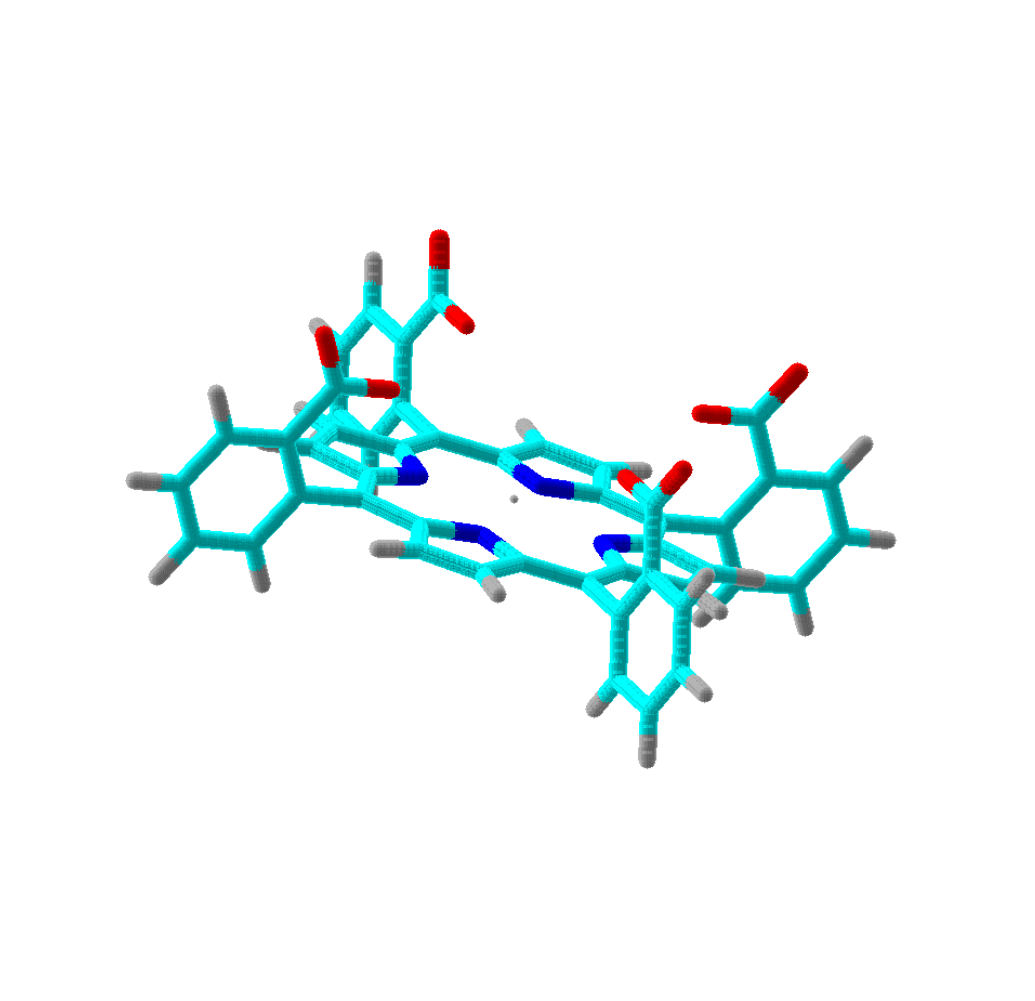
Figure 4. One of the conformers of MnT(2-C)PP shown as a tube structure in 3D. It corresponds to conformer (+,+,+,+) in Figure 3. Dark blue are nitrogens in the pyrrole rings. Red tubes are oxygens in the carboxy groups. Light blues are carbons and grey tubes are hydrogens. The Mn(III) ion is in the center as an isolated tiny